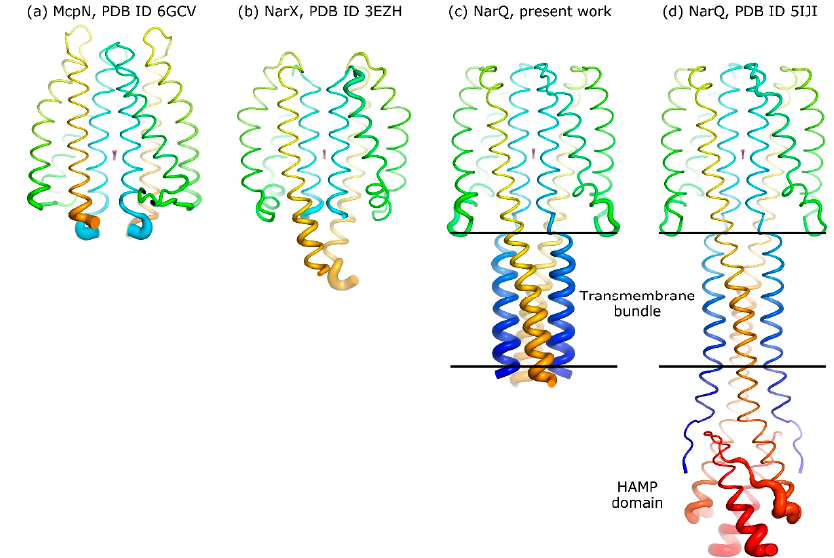
Figure 3. Disorder in the available crystallographic structures of fragments of nitrate-binding two-component signaling system (TCS) proteins. Thickness of the protein backbone tube is proportional to the B-factor. Rainbow coloring highlights the progression of the polypeptide chain from the N terminus (blue) towards the C terminus (red). ( a ) Sensor domain of McpN, PDB ID 6GCV [30]. B-factor range is 11–98 Å 2 , average is 23 Å 2 . ( b ) Sensor domain of NarX, PDB ID 3EZH [28]. B-factor range is 13–86 Å 2 , average is 30 Å 2 . ( c ) Sensor and TM domains of NarQ, present work. B-factor range is 20–192 Å 2 , average is 71 Å 2 (20–122 Å 2 and 50 Å 2 for the sensor domain, correspondingly). ( d ) Sensor, TM, and HAMP domains of NarQ, PDB ID 5IJI [13]. B-factor range is 15–99 Å 2 , average is 34 Å 2 . Whereas the residues in the ligand-binding region are always well-ordered, the residues closer to the truncation site are progressively disordered.